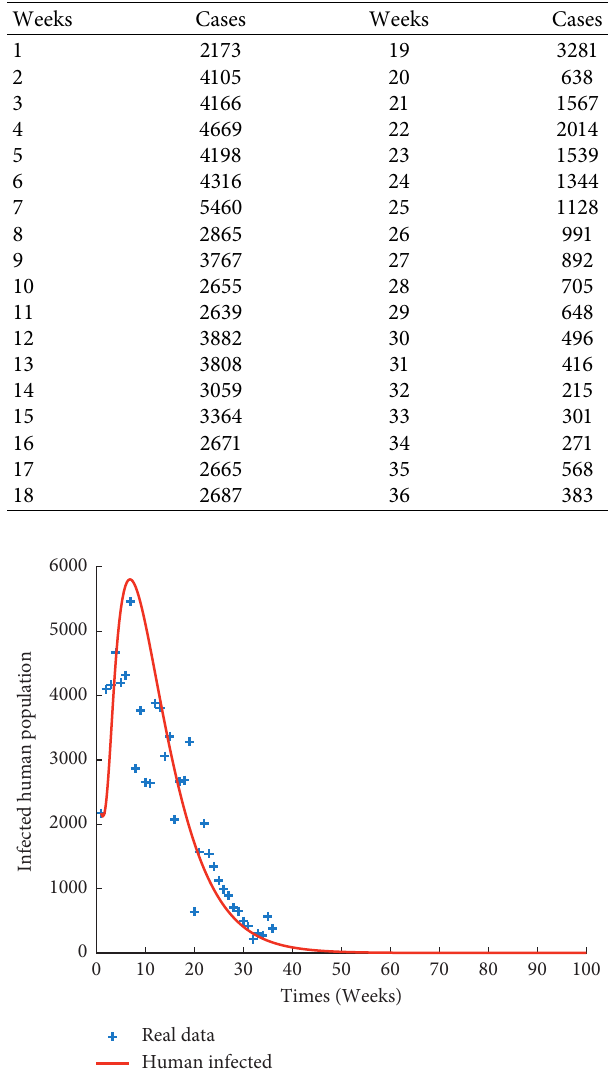
Figure 14: Best fit of the ZIKV mathematical model (1) with a scale factor to the time-series data of Zika in Colombia corresponding to the year 2016. The red solid line shows the best model